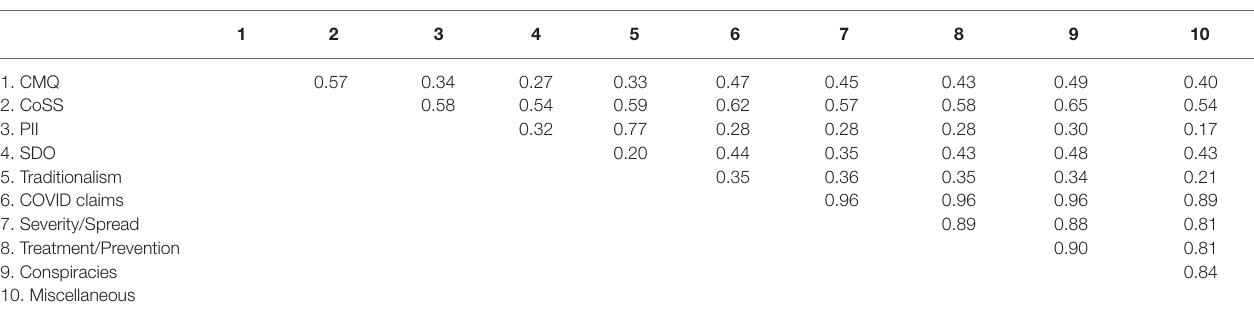
TABLE 3 | Pearson product moment